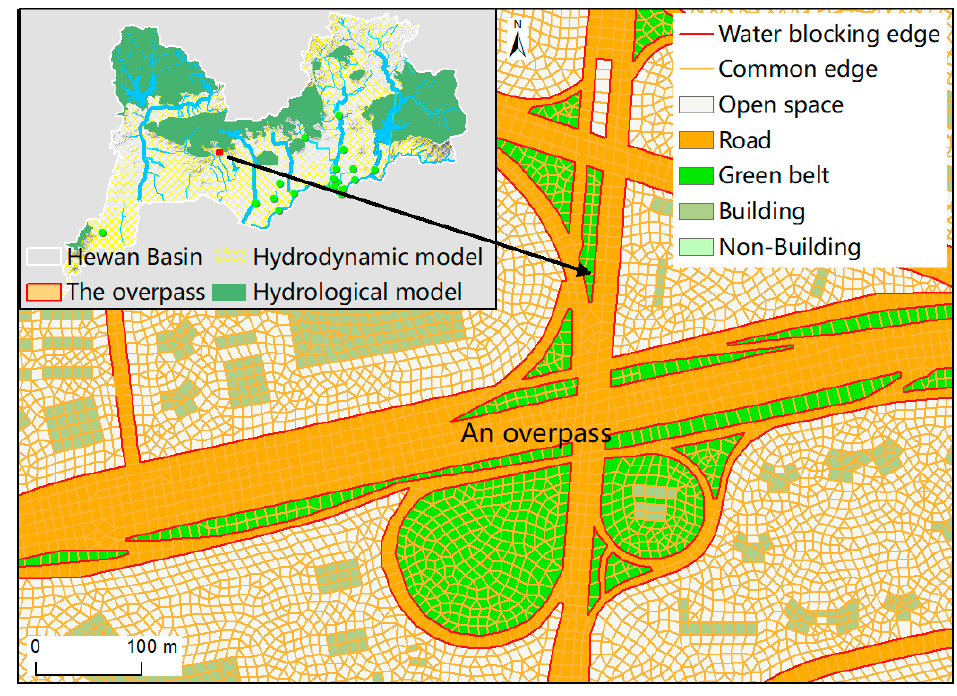
Figure 6. Mesh of 2D model.